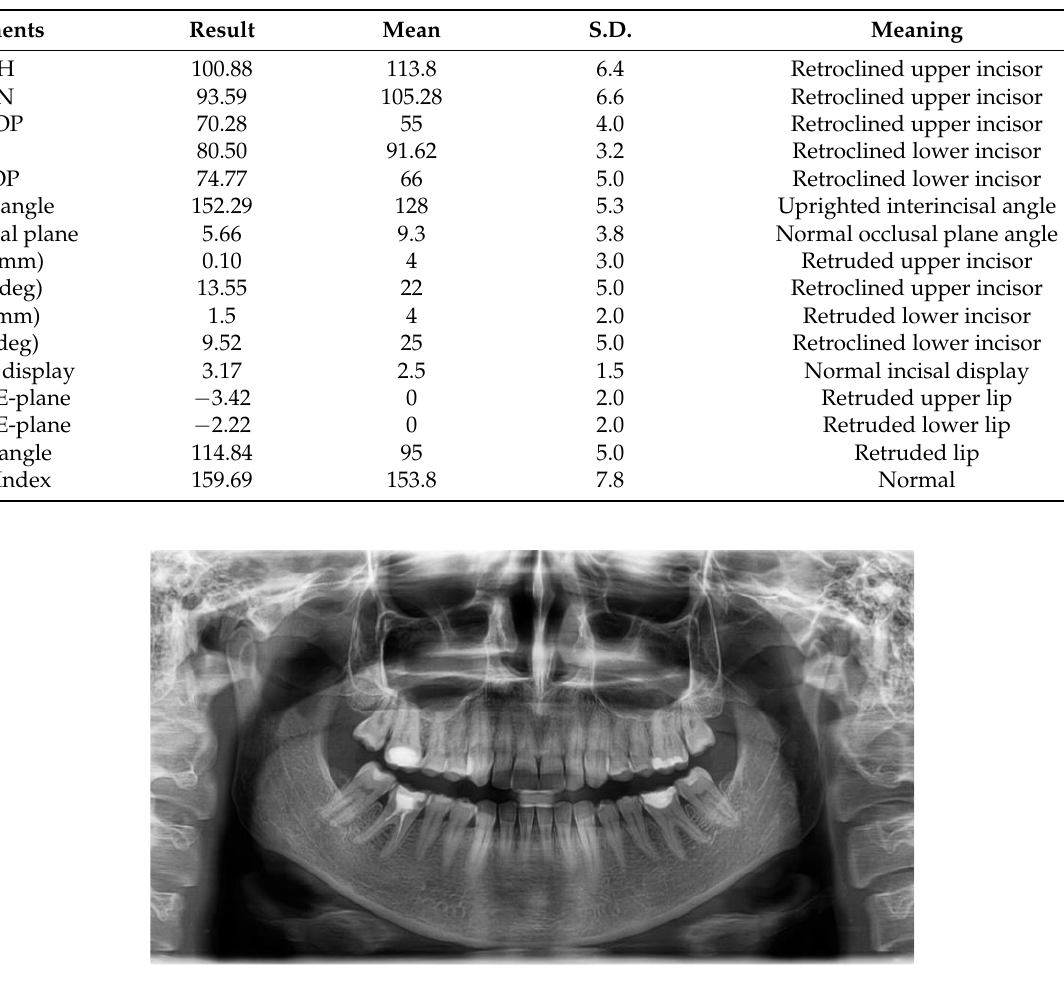
Figure 3. Initial panoramic radiograph.